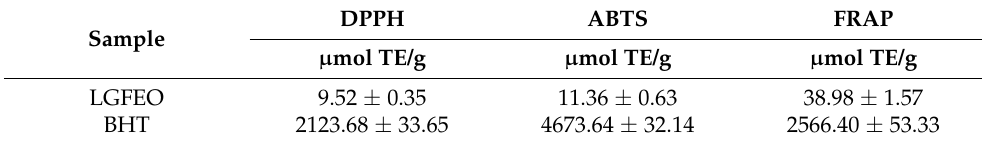
Table 3. Antioxidant activity of the LGFEO.